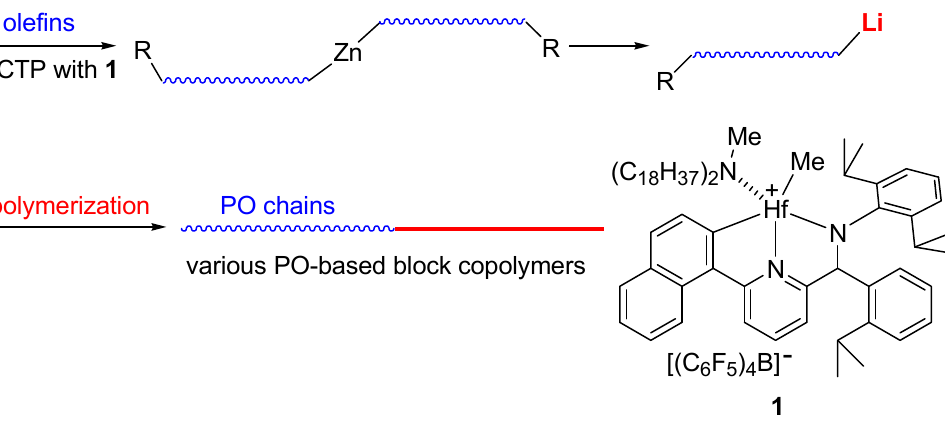
Scheme 1. Synthetic scheme for various polyolefin-based block